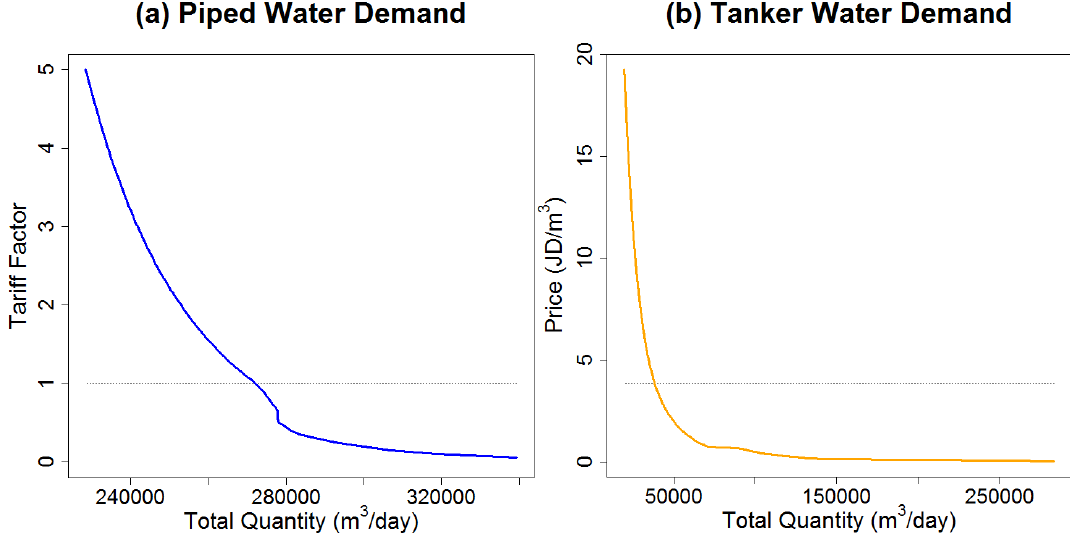
Figure 4. Sensitivity analyses. ( a ) Piped water demand (blue) as a function of the piped water tariff factor; ( b ) Tanker water demand (orange) as a function of the tanker water price. The baseline values of both variables are indicated by horizontal grey